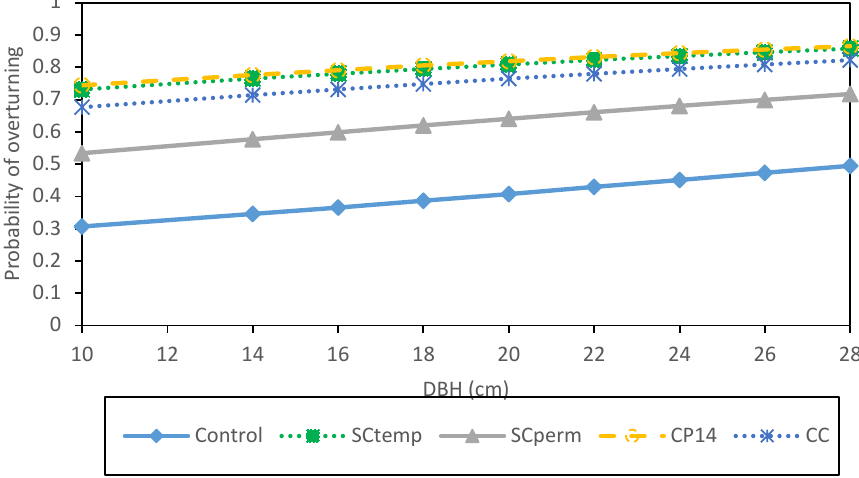
Figure 6. Probability of overturning vs. standing dead mortality, by treatment and dbh [36].